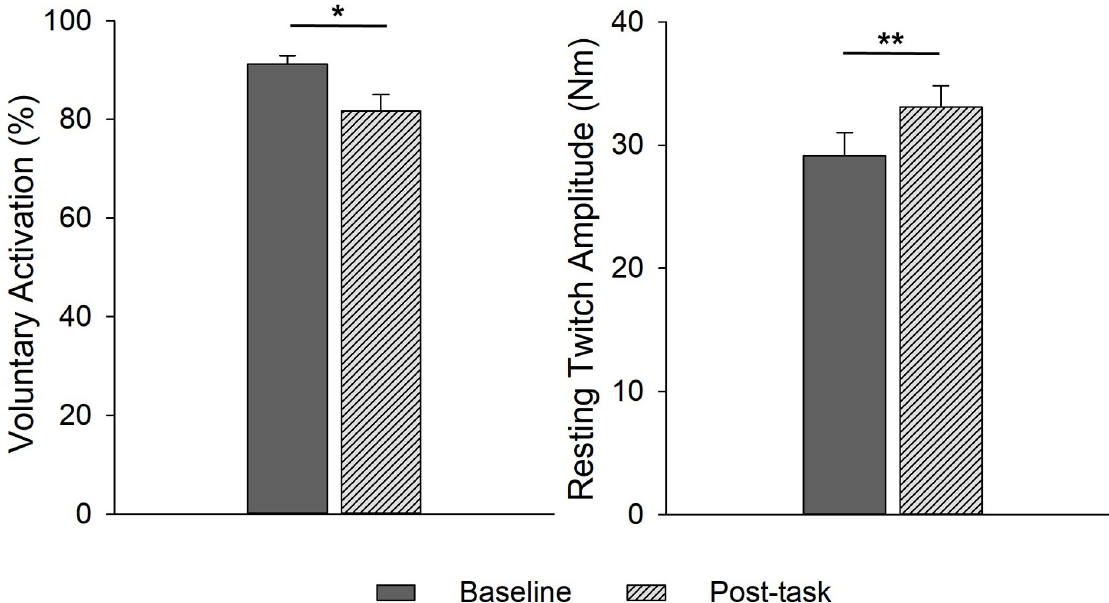
Fig 5. Voluntary activation (A) and resting twitch amplitude (B) before and after the SLHR task in males and females pooled. Voluntary activation decreased (p = 0.01) and resting twitch amplitude increased (p < 0.001) following the SLHR task for males and females (there were no sex differences in response to the SLHR). � p < 0.05; �� p <